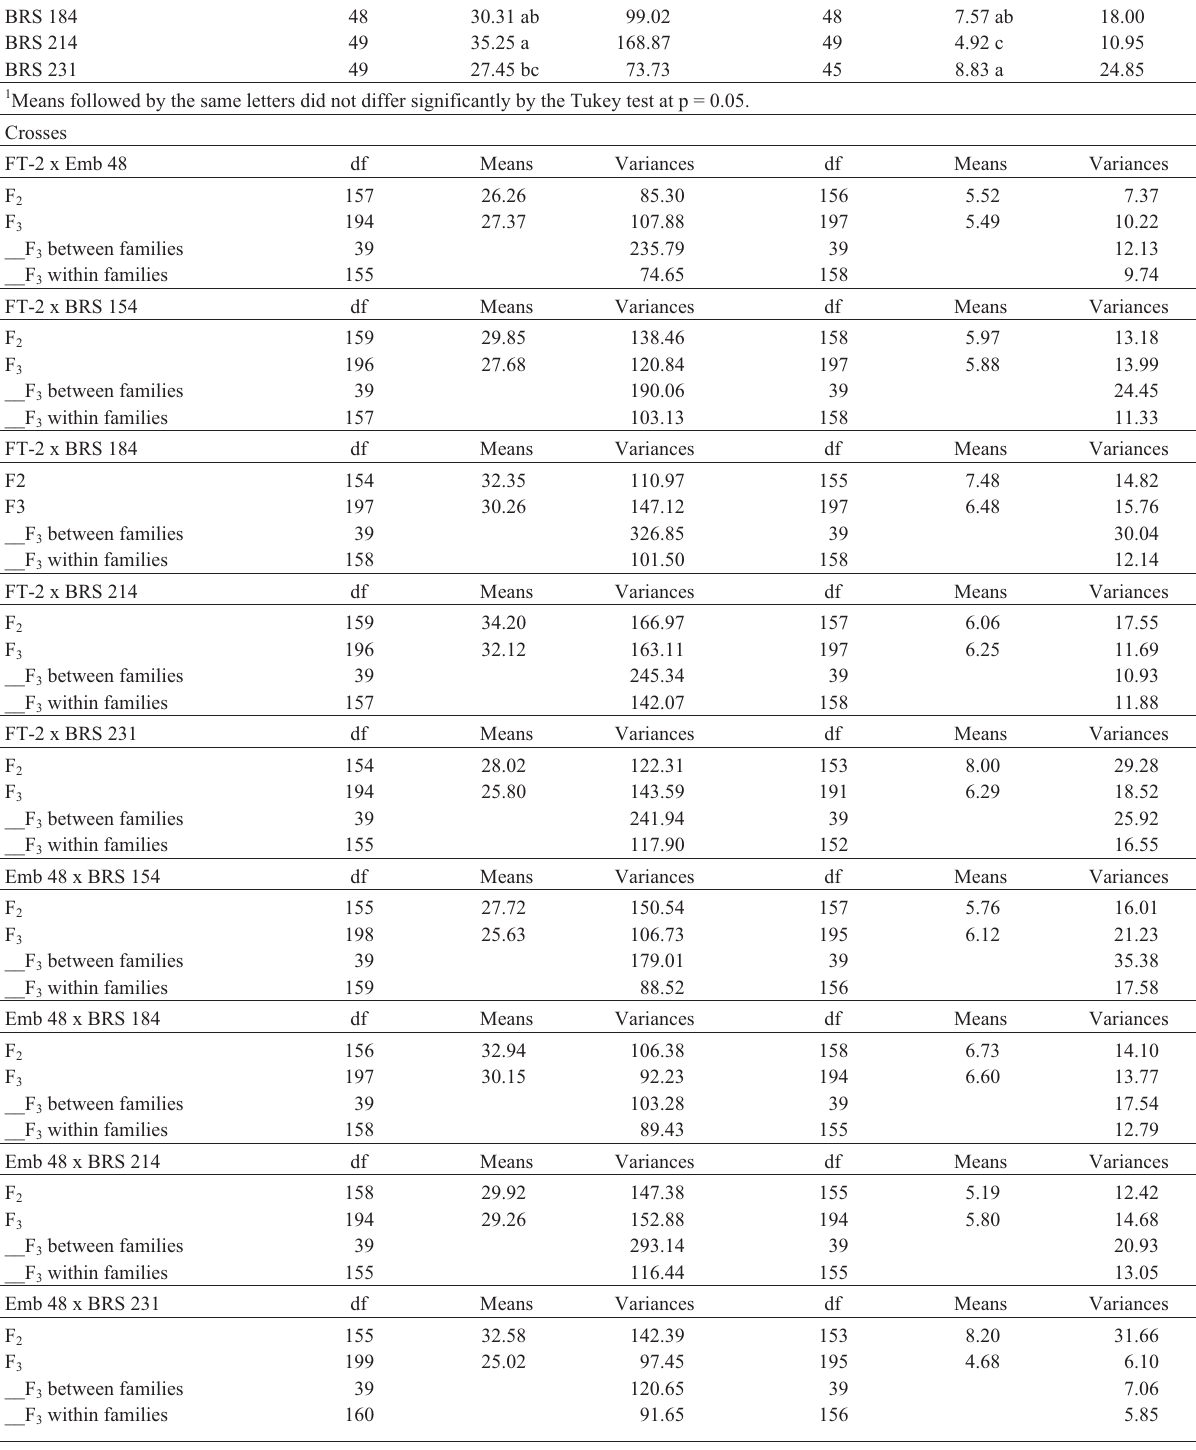
Table 1 - Degrees of freedom (df), means and variances of the six parent soybean cultivars and their derived biparental cross F periments I and II. Data refer to grams per plant.